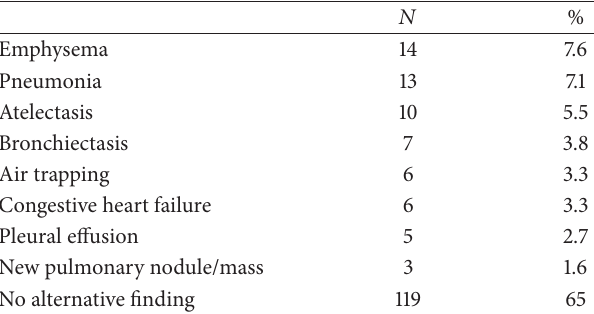
Table 5: Most common alternative or incidental findings on CTPA of patients without PE ( 𝑁 = 183